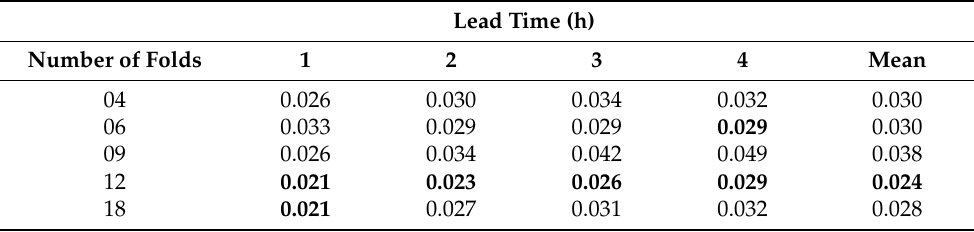
Table 4. CRPS of the ensemble surrogate models for different cross-fold ensemble configurations in the training/validation dataset. The lowest (best) value of each column is highlighted in